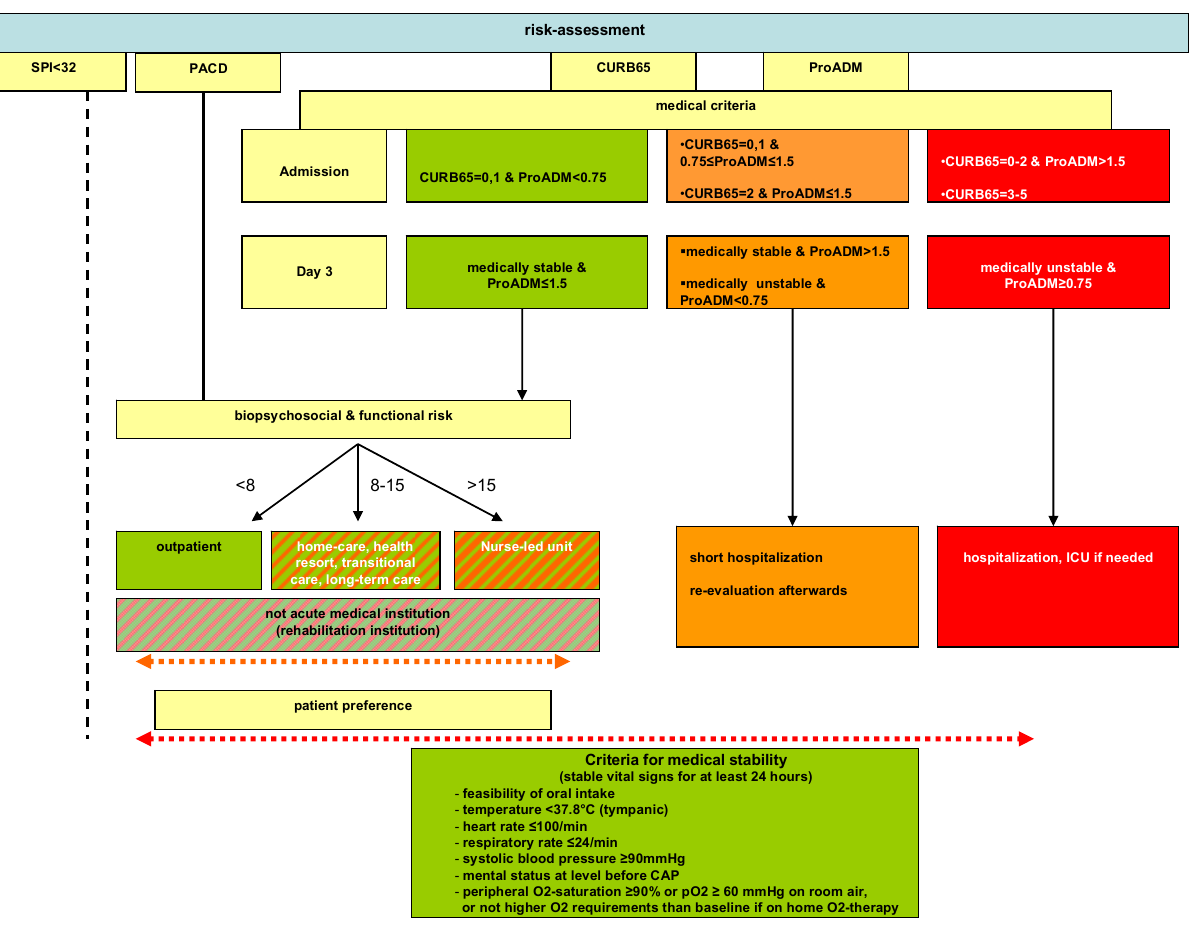
Figure 1. Algorithm of risk assessment for triage decisions on admission and during